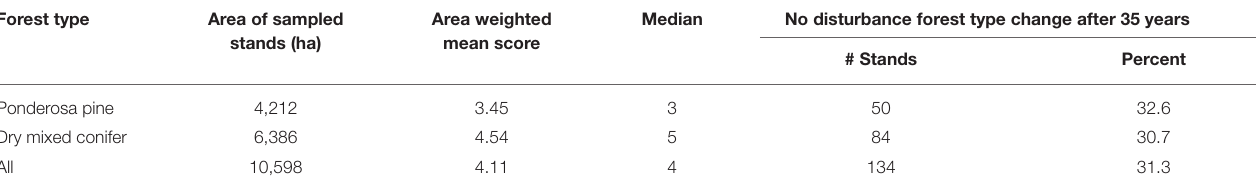
TABLE 2 | Area of sampled stands shown in Figure 1 , area weighted mean and median of resilience scores by forest type, and number and percent of stands indicating a forest type change after 40 years of no disturbance. Forest type Area of sampled Area weighted stands (ha) mean score